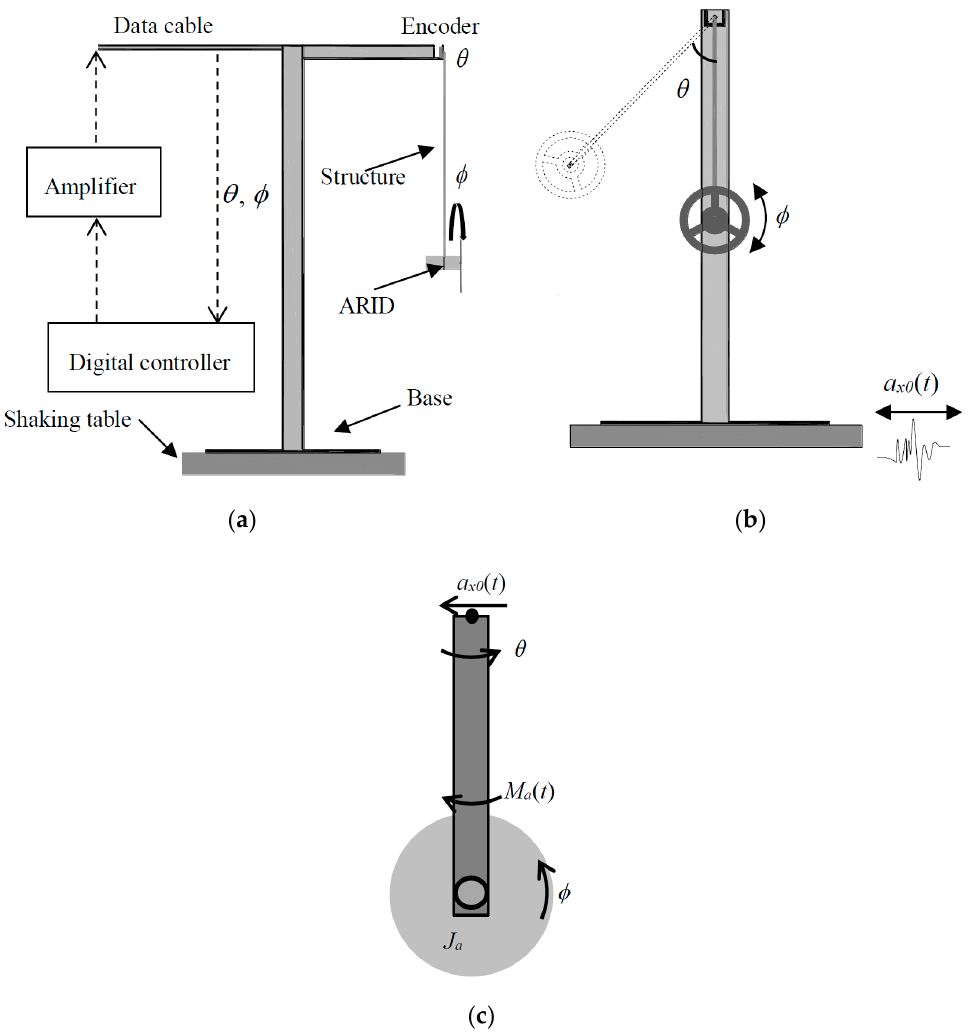
Figure 4. Experimental system design: ( a ) Experimental system sketch; ( b ) suspended structure with the ARID system; ( c ) analytical model.